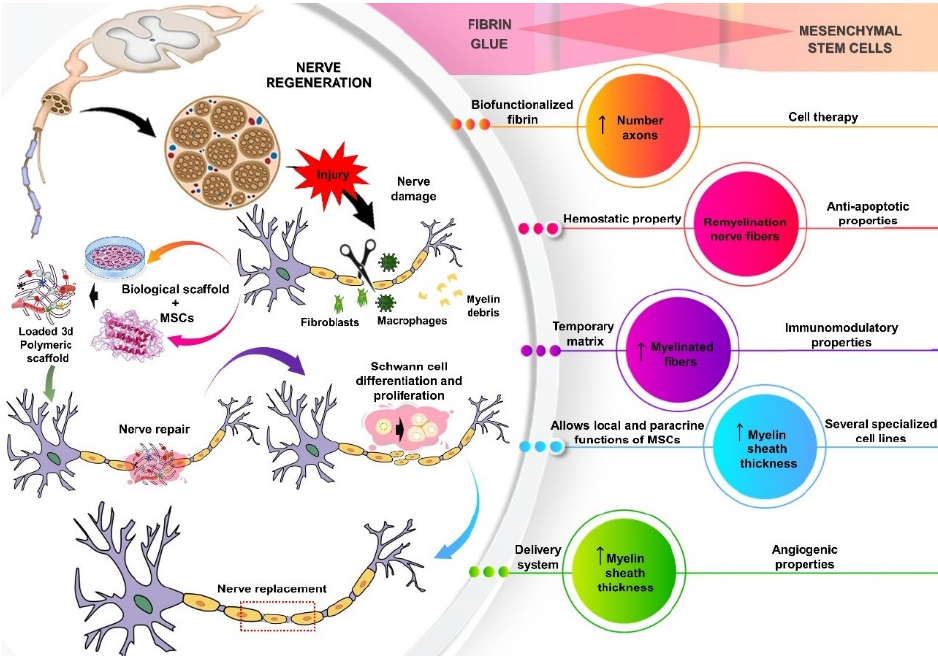
Figure 3. Schematic illustration of central or peripheral nervous system regeneration through cell therapy associated with a 3D polymeric matrix of fibrin. Furthermore, it explains the intrinsic characteristics of each, a proportionally synergistic effect when associated. The mesenchymal stem has angiogenic, anti-apoptotic and immunomodulatory properties, in addition to its ability to differentiate into several specialized cell lines. Fibrin glue has hemostatic properties and acts as a temporary matrix that favors cell-matrix interactions and allows local and paracrine functions of MSCs. In the nervous repair process, events occur that signal a disturbance in the homeostasis of the microenvironment, which leads to changes in cell metabolism, with consequent activation of several signaling pathways and regulation of gene expression. At this stage, the MSCs differentiate into Schwann cells, they overexpress neurotrophins and other growth factors involved in neuronal regeneration and the binding sites in the fibrin network provide interaction with macrophages and fibroblasts, aiding Wallerian degeneration, phagocytizing fragmented axons and myelin debris and sequentially regeneration nervous.